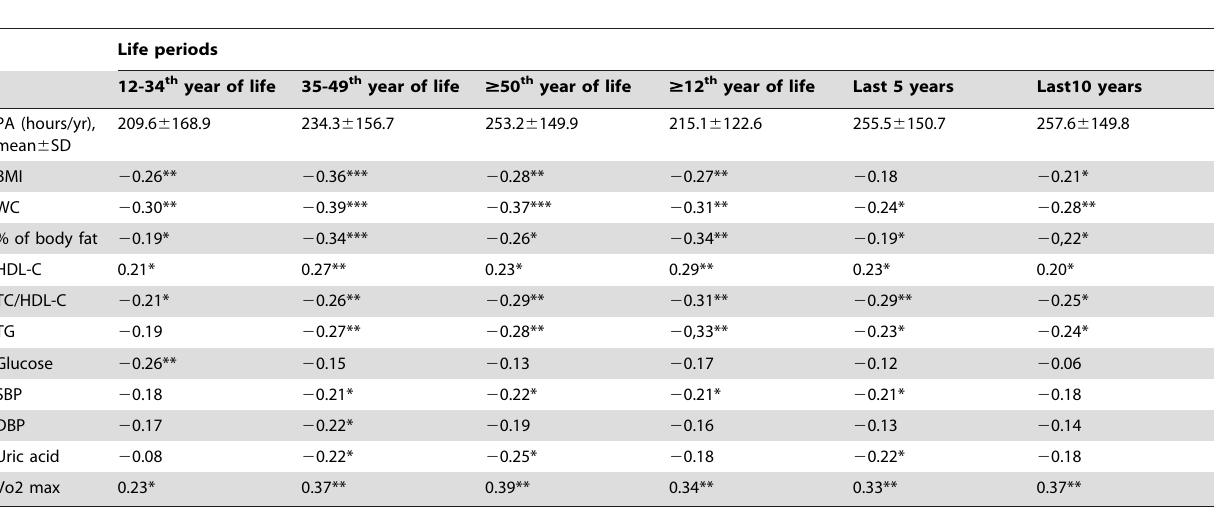
Table 3. Correlation coefficients of traditional CVD risk factors to LTPA in different life periods assessed by historical PA questionnaire.